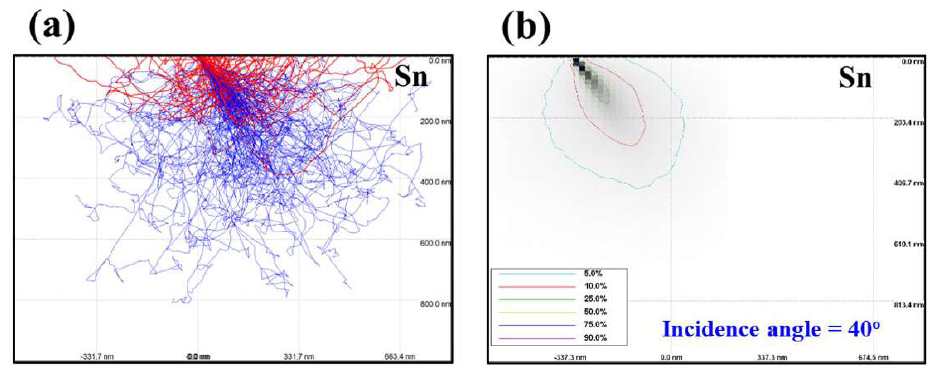
Figure 6. ( a ) Electron trajectory and ( b ) electron energy loss contour when electrons are incident on Sn at an anode voltage of 15 kV at 40 degrees.